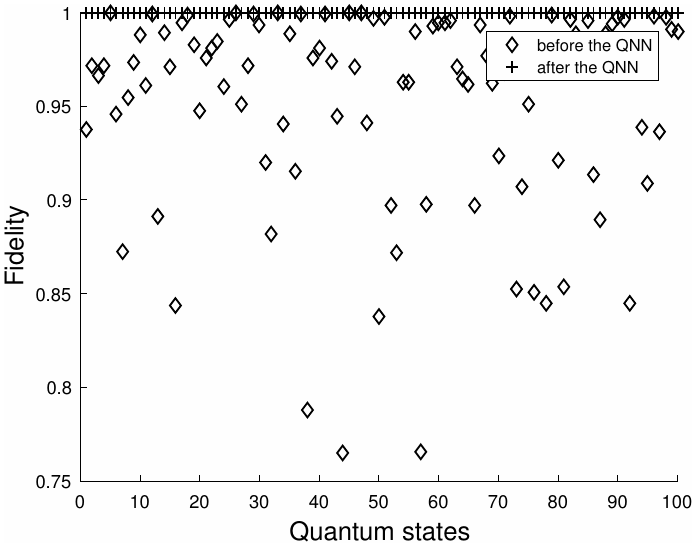
Figure 6. The fidelity of quantum states before and after training the QNN on the quantum state of the first